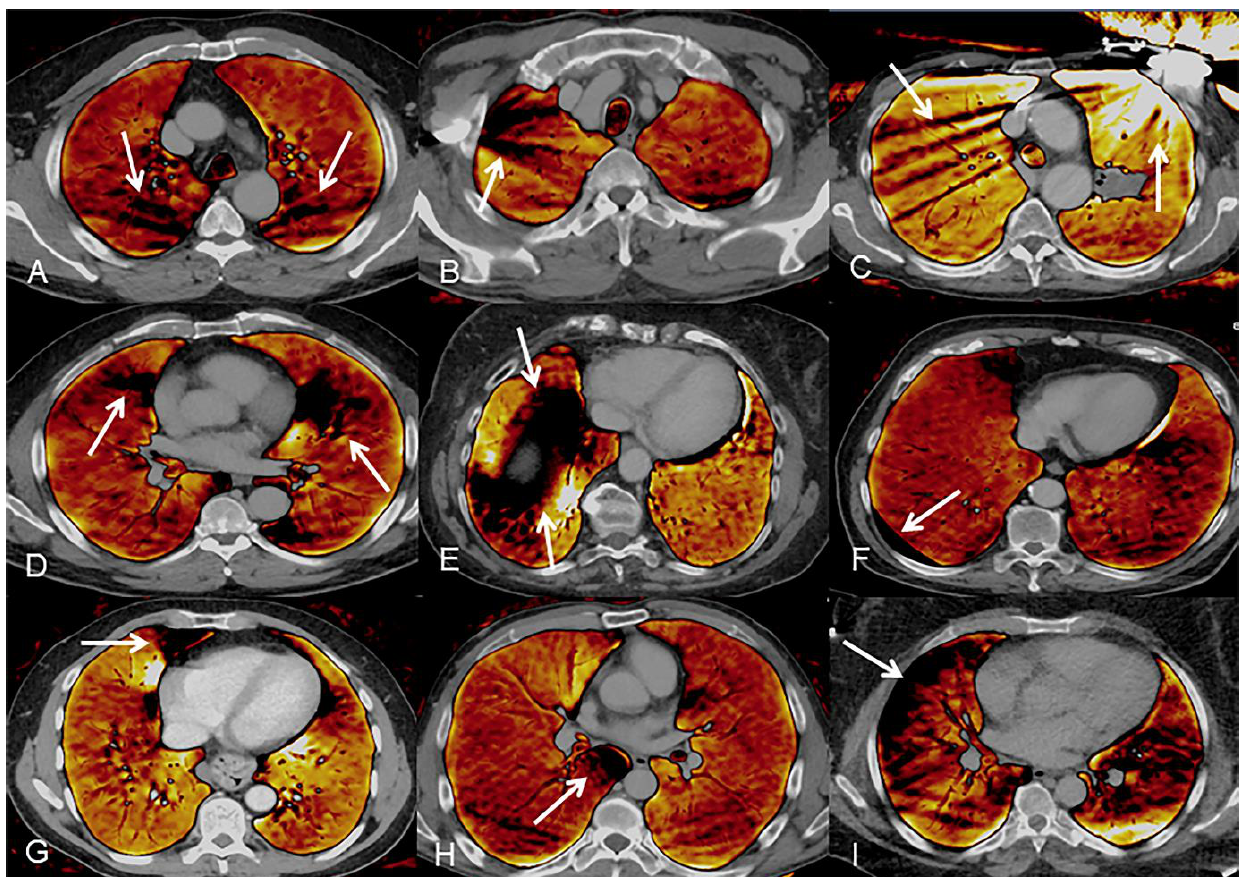
Figure 4. Examples of image artifacts in the perfusion blood volume (PBV) images: ( A ) streak artifacts along the spine, ( B ) streak artifacts around venous contrast agent inflow, ( C ) streak artifacts around metallic objects, ( D ) rotation artifacts around the heart, ( E ) rotation artifacts around the diaphragm, ( F ) Dual-Source artifacts, ( G ) anterior recess artifacts, ( H ) posterior recess artifacts, ( I ) subpleural artifacts.